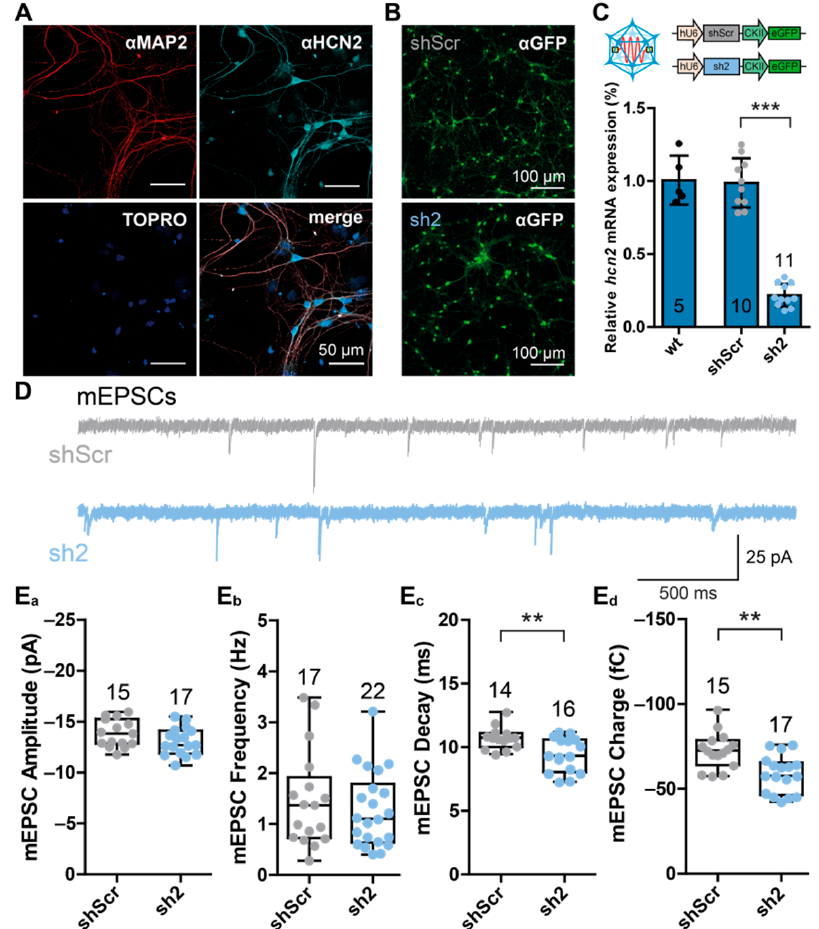
Figure 1. RNAi-mediated knock-down of hcn2 transcripts altered dendritic integration properties of PHNs. ( A ) Representative immunofluorescence images showing the expression of the HCN channel isoform 2 (HCN2) in primary hippocampal neurons (PHNs). The neuron-specific MAP2 protein (red) and HCN2 proteins (cyan) were stained with specific anti ( α )-MAP2 and α -HCN2 antibodies combined with fluorescently labeled secondary antibodies. Nuclei were labeled with TOPRO (blue). ( B ) Representative immunofluorescent images showing eGFP (green) expression in rAAV9-transduced PHNs either encoding control shRNA (shScr, upper image) or hcn2 -specific shRNA (sh2, lower image). ( C ) qRT-PCR analysis of hcn2 transcript levels of wildtype PHNs and PHNs treated with either shScr-expressing or sh2-expressing rAAVs. Transcript levels were normalized to gapdh , and values shown are normalized to wildtype hcn2 transcript numbers. cDNA was prepared from indicated numbers of coverslips obtained from at least 3 different animals. Cartoons of the rAAV9 constructs are displayed above the images. ( D ) Representative current traces showing miniature excitatory postsynaptic currents (mEPSCs) in PHNs treated with shScr- (gray) or sh2-encoding (blue) rAAVs. ( E ) Influence of HCN2 knock-down on ( E a ) mEPSC amplitude; ( E b ) mEPSC frequency; ( E c ) mEPSC decay time, calculated by fitting the decay phase by a mono-exponential decay equation; and ( E d ) on mEPSC charge, calculated by the integral of the synaptic events. Data are depicted as boxplots. Numbers above boxplots indicate the number of neurons analyzed by patch-clamp electrophysiology. Statistical significance was assessed using the unpaired two-tailed Student’s t -test, ** p < 0.01; *** p <